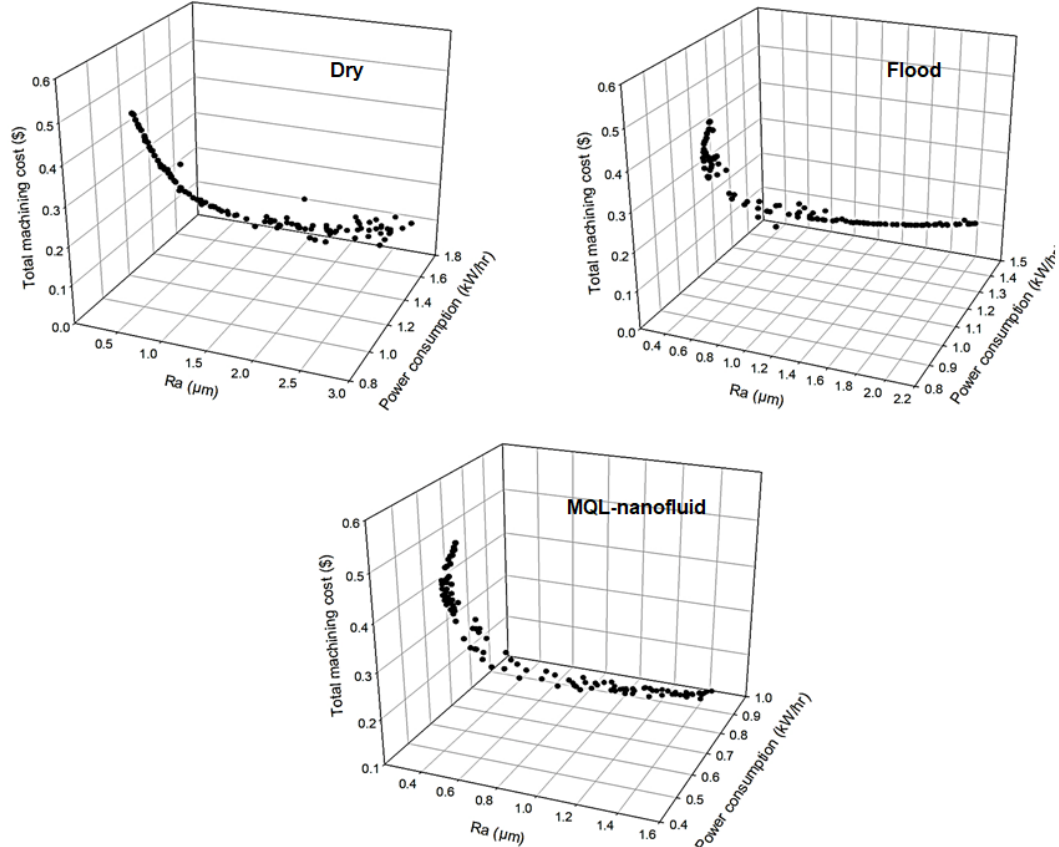
Figure 12. The 3-D Pareto front for Model III.